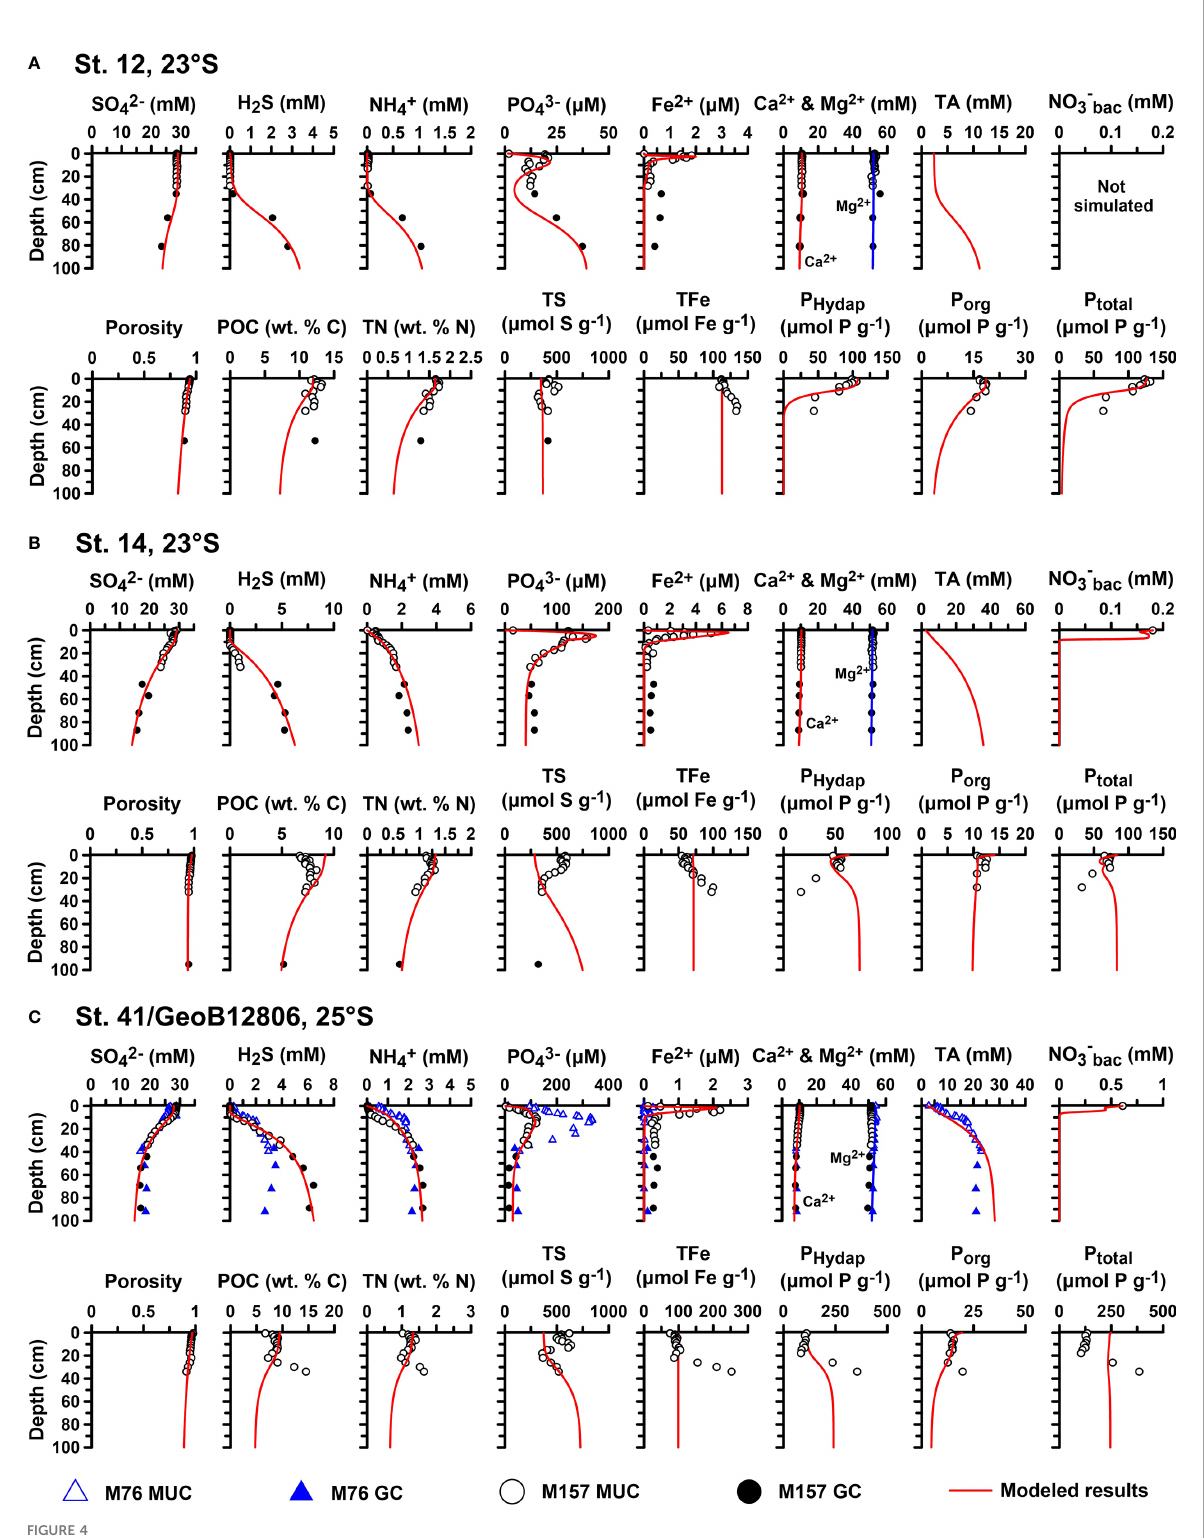
FIGURE 4 Modeled (curves) and measured (symbols) depth pro fi les of solutes, porosity, and solid species in the upper 100 cm at (A) St. 12, (B) St. 14, and (C) St. 41/GeoB12806. Sediments were collected with a multiple-corer (MUC) (open symbols) and a gravity corer (GC) ( fi lled symbols) during R/ V Meteor cruises 157 (circles) and 76